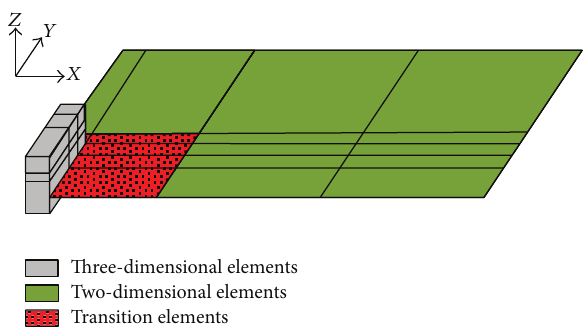
Figure 12: Multidimensional mesh for patched plate with edge